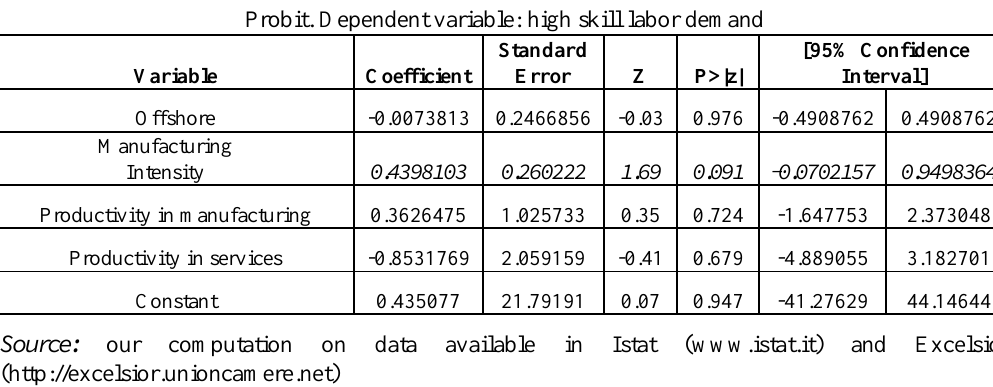
Table 12 : Explaining Skill Shortage in Italian Provinces 2008-2011 Probit. Dependent variable: skill shortage